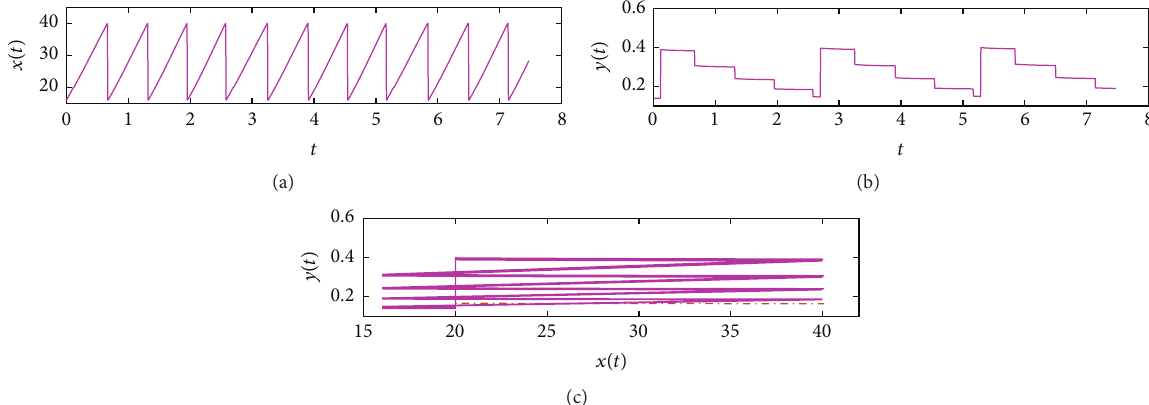
Figure 10: The change in prey density (a), predator density (b), and phase diagrams (c) starting from (𝑥 0 ,𝑦 0 ) = (16, 0.14) with 𝑝 = 0.6 , = 20 , ℎ = 40 , 𝑦 (ℎ ) = 0.1664 , and 𝛼 𝑞 = 0.2 , ℎ 1 2 𝜏 1